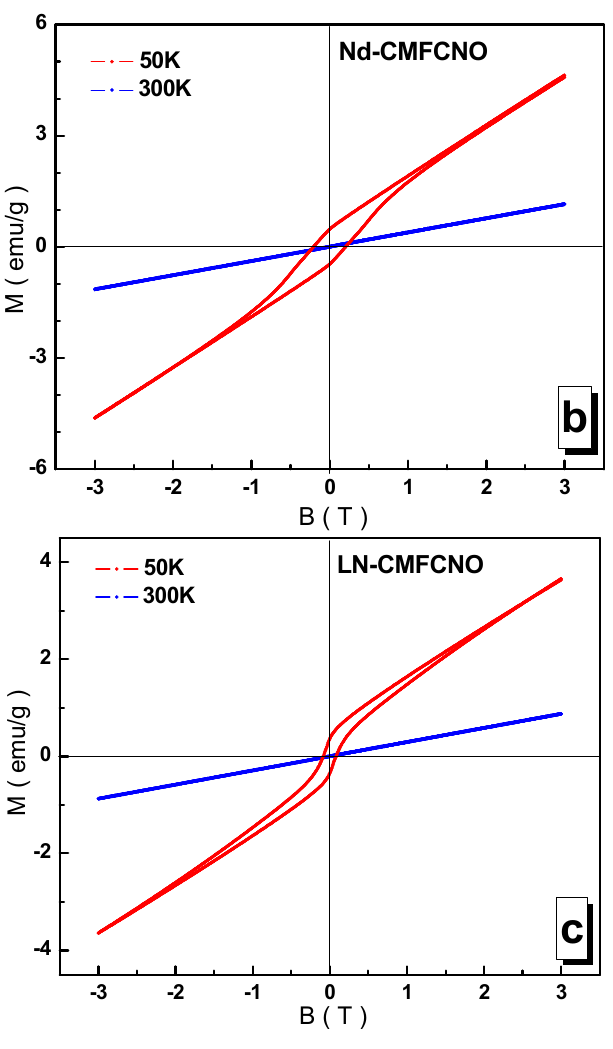
Figure 10. Field dependences of the specific magnetization for the La-CMFCNO ( a ), Nd-CMFCNO ( b ) and LN-CMFCNO ( c ) samples at 50 K (red line) and 300 K (blue line).